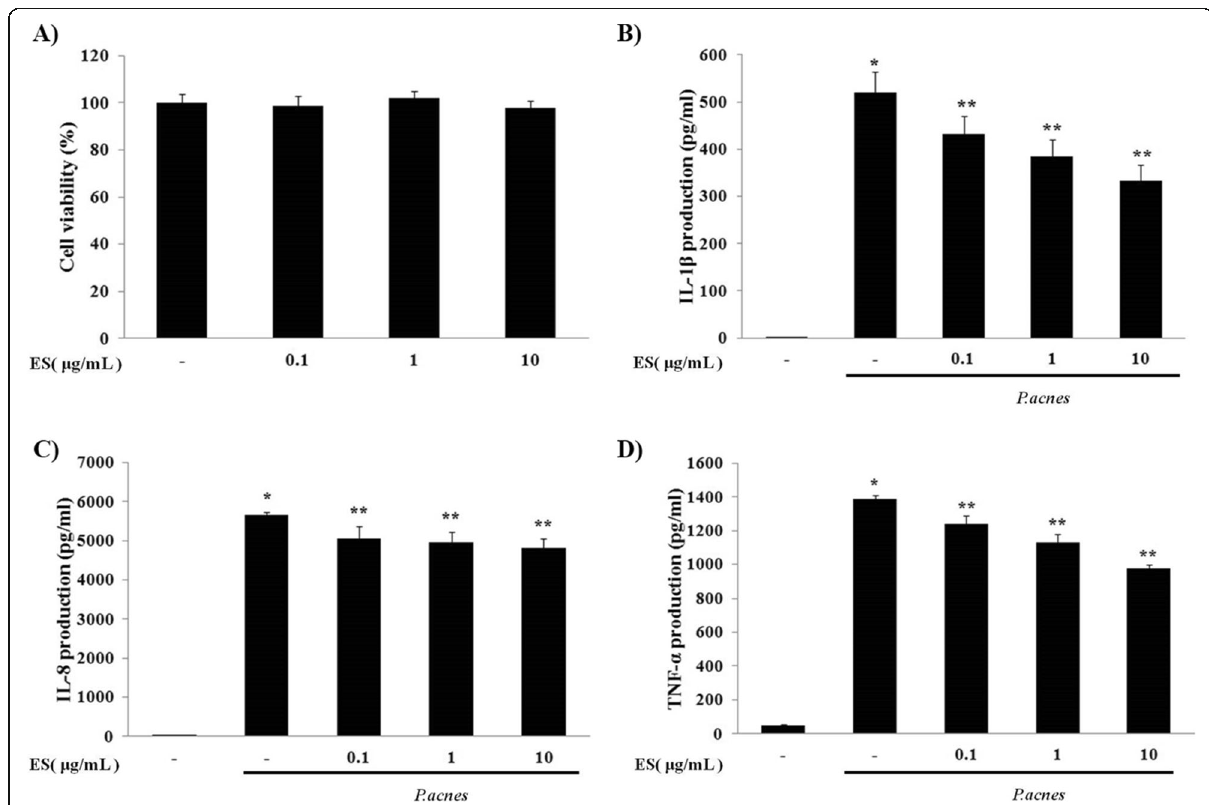
Fig. 2 Effect of ES on cell viability and P. acnes -induced pro-inflammatory cytokines in THP-1 cells. ( a ) Cell viability of ES was determined by MTT assay in THP-1 cells. THP-1 cells were treated with 0.1, 1 and 10 μ g/ml of ES for 24 hrs. ELISA results demonstrate that ES suppressed the secretion of ( b ) IL-1 β , ( c ) IL-8 and ( d ) TNF- α in P. acnes -stimulated THP-1 cells. Values represent mean ± S.E.M. Data were analyzed by Tukey post hoc test ( * p < 0.05 versus control and ** p < 0.05 versus P.acnes